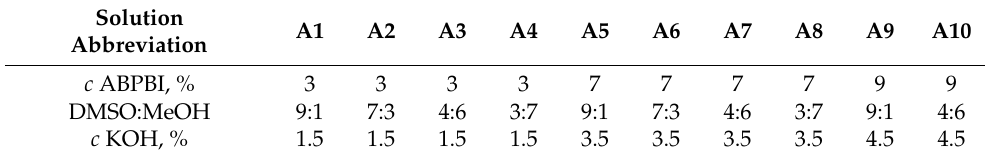
Table 1. ABPBI solutions composition